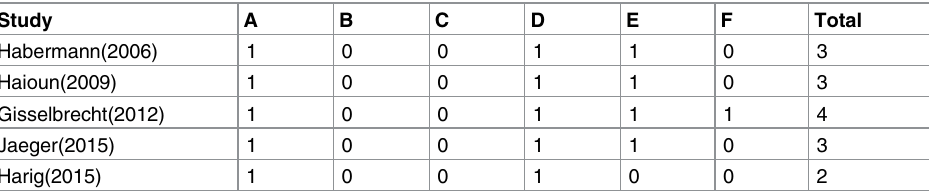
Table 2. Study quality.